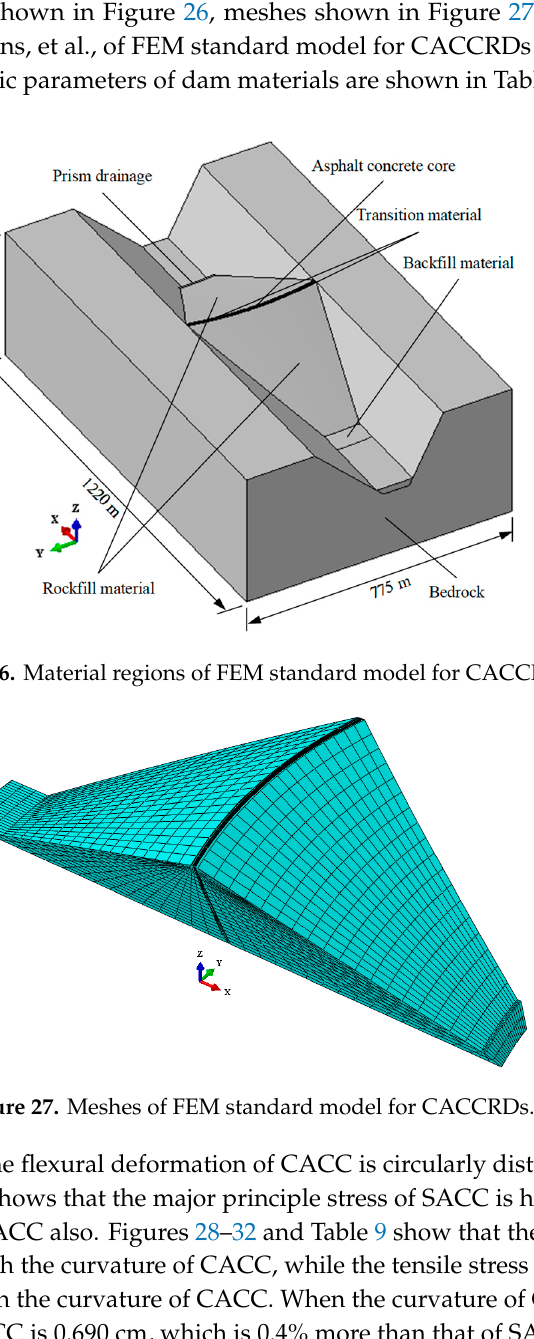
Table 9. Flexural deformation, tensile stress, tensile stress area, and tensile safety factor of CACC with different curvatures of CACC.